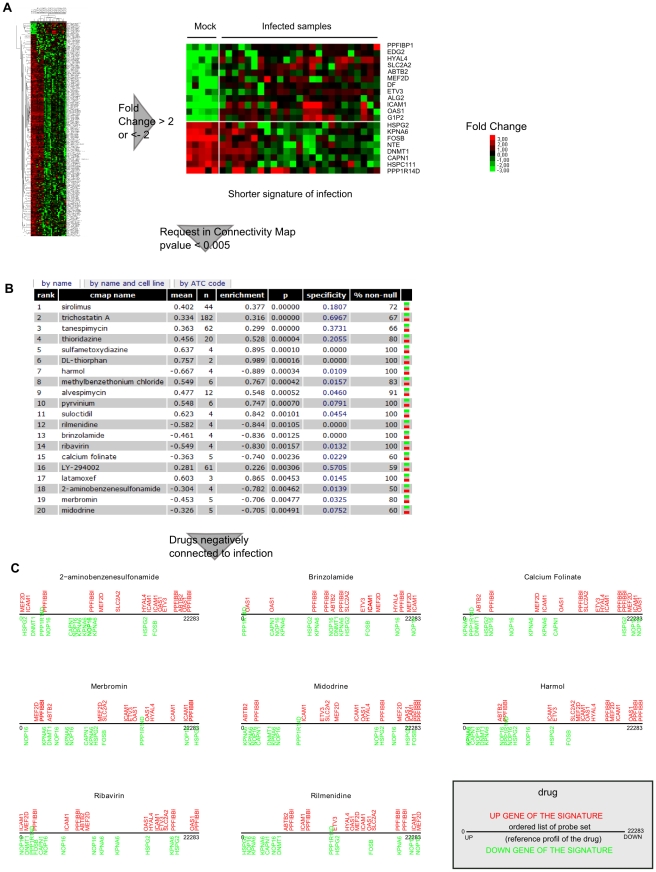
Gene expression-based screening identifies eight potential antiviral molecules.A. List of cellular genes chosen to query the Connectivity Map. A circumscribed signature of infection was derived from the 300 genes discriminating mock and infected samples by selecting genes with a fold change > 2 or <−2. The fold change is defined as the ratio of the mean gene expression in infected samples to the mean for the corresponding mock infection in log2. This selection resulted in a list of 20 genes, 12 being up-regulated during infection and 8 down-regulated (see Table 1). These genes constituted the signature used to query the online database Connectivity Map. B. Drugs with significant enrichment to influenza virus infections in the Connectivity Map. Significance cut-off was set at p-value <0.005. The permutation p-value estimates the likelihood that the results would be observed by random chance. Mean: the arithmetic mean of the connectivity scores for the post-dose changes (or instances) by the given molecule; n: the number of instances of a given molecule in the CMAP database; Enrichment: a measure of the enrichment of those instances in the order list of all instances, Positive enrichment scores are of interest if perturbagens inducing the biological state represented by the signature used to produce the result are sought. Likewise, if reversal or repression of the biological state encoded in the query signature is required, perturbagens with negative enrichment scores are of interest. The specificity value is defined as the frequency at which the enrichment of a set of instances equals or exceeds that of the same set of instances in queries executed on 312 published, experimentally derived signatures using the Molecular Signatures Database. Lower values are associated with a greater specificity; the non null percentage represents a measure of the support for the connection between a set of instances and a signature of interest based on the behavior of the individual instances in that set. C. 8 molecules are negatively connected to influenza virus infection (p-value <0.005). A graphical representation of the location of the signature of infection is depicted for each molecule, taking the instance with the most negative connectivity score of each molecule. The x-axis represents the genes of the expression profile of the molecule, rank ordered according to their differential expression relative to the control. The location of each gene of the infection signature is appreciated along the x-axis.